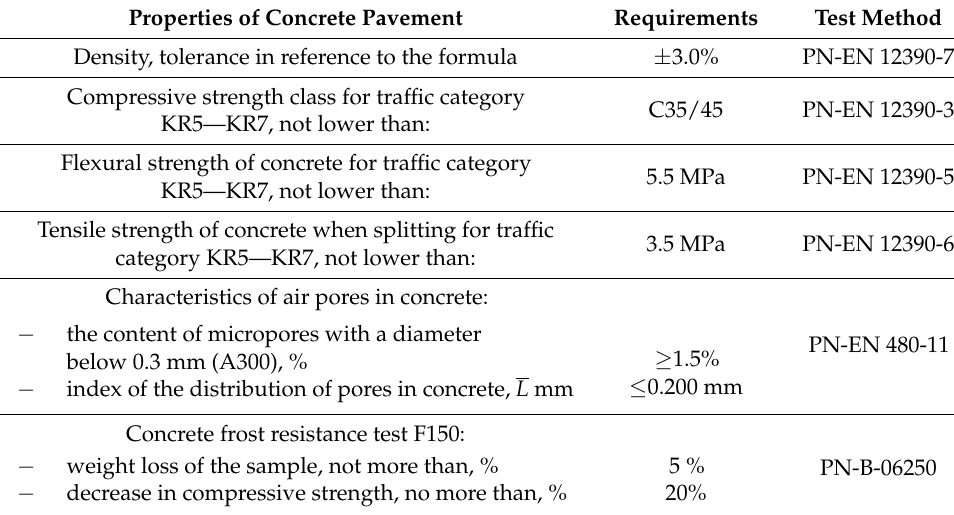
Table 2. Requirements for the concrete pavement for traffic categories KR5—KR7.